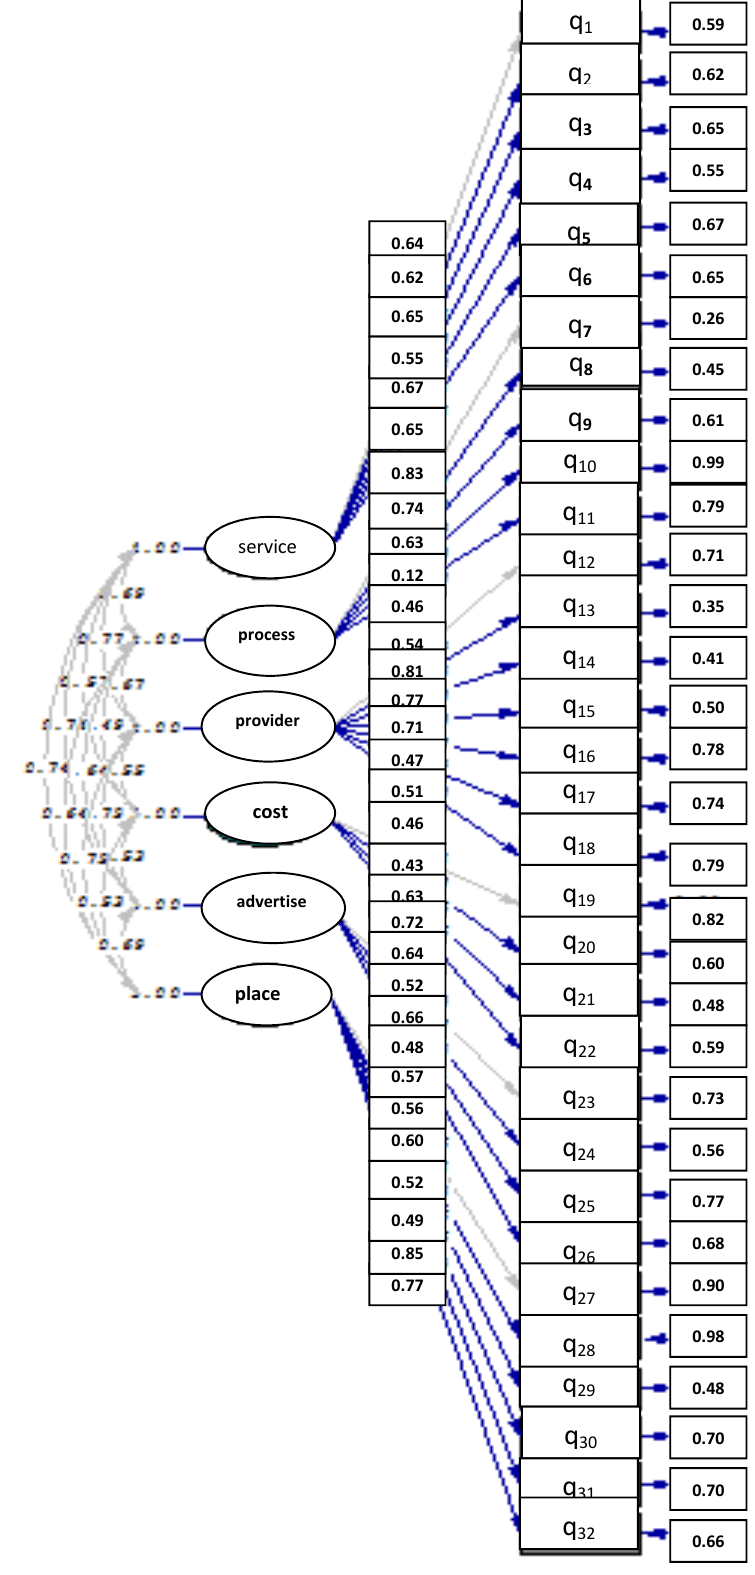
Figure 1. The final model (the effect of variables in public